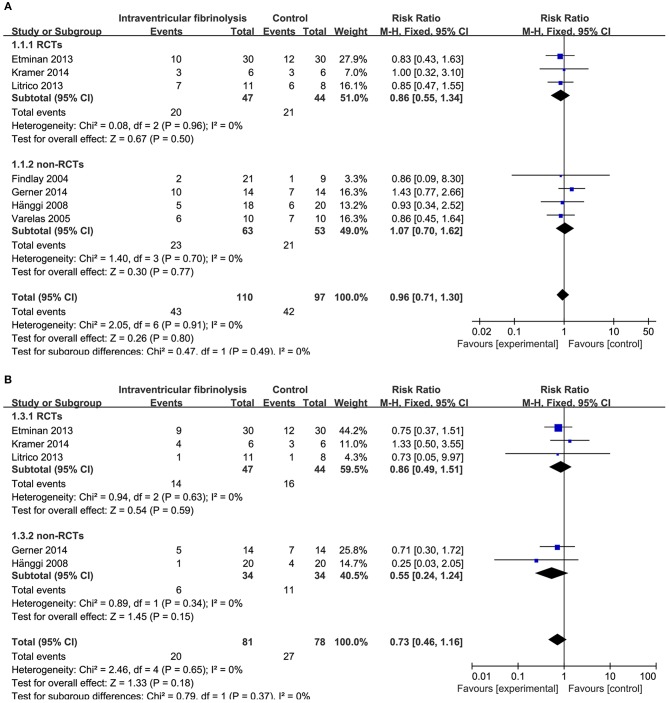
Meta-analysis of associations between intraventricular fibrinolysis and the risk of poor neurologic recovery (A) or the risk of DIND (B) in aSAH patients. aSAH, aneurysmal subarachnoid hemorrhage; CI, confidence interval; DIND, delayed ischemic neurologic deficit; M–H, Mantel–Haenszel method; RCTs, randomized controlled trials.